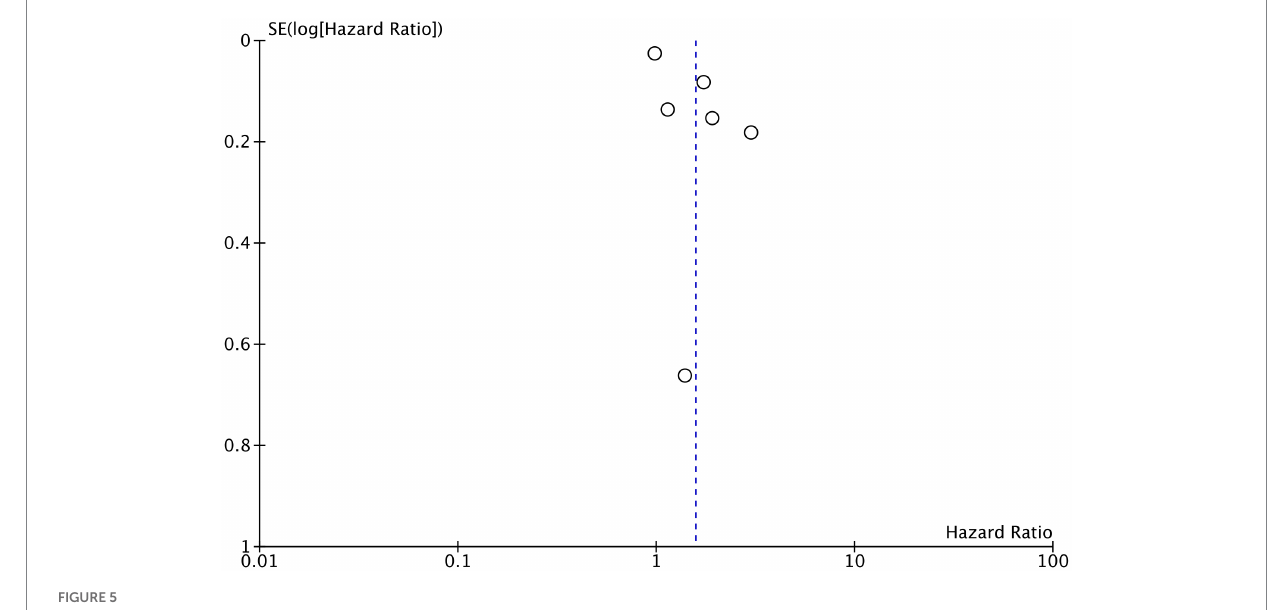
FIGURE 5 Funnel plot for the meta-analysis of MACE with PNI as a categorical variable.